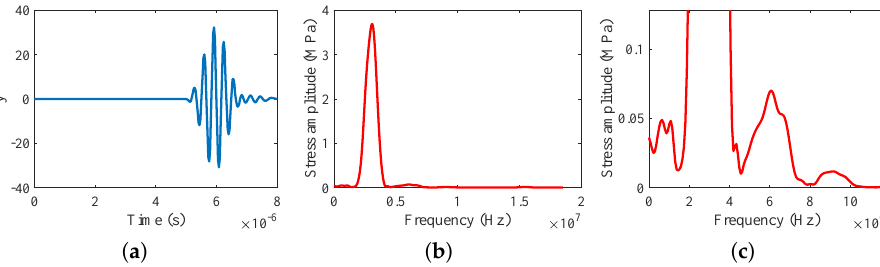
Figure 14. Simulation result of the first order perturbation when C 1 = − 2,000,000: ( a ) Time domain signal. ( b ) Spectrum of signal. ( c ) Harmonic of signal.